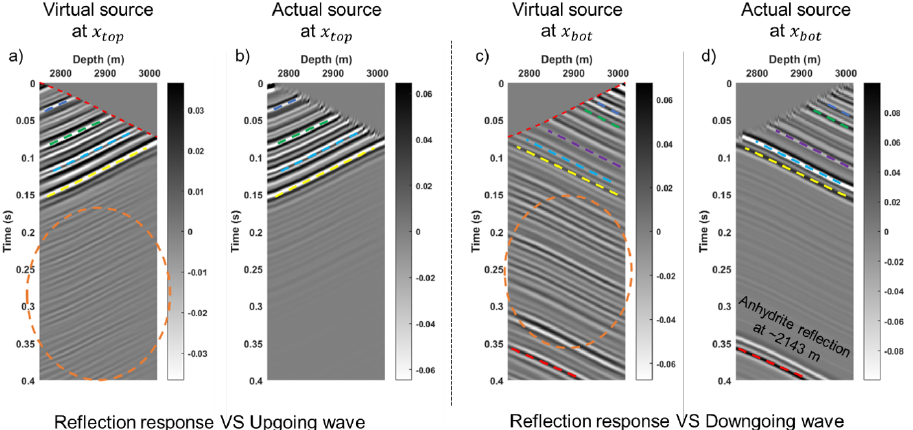
Figure 11. Reflection response estimation using synthetic shot data. ( a , c ) show the reflection response with a virtual source at the top and bottom geophone. ( b ) The upgoing wave from an actual source at the top geophone. ( d ) Downgoing wave from an actual source at the bottom geophone. Colored dashed lines represent events in the interferometry result that match with the up- or downgoing events from the model. The dashed circle shows artifacts of spurious